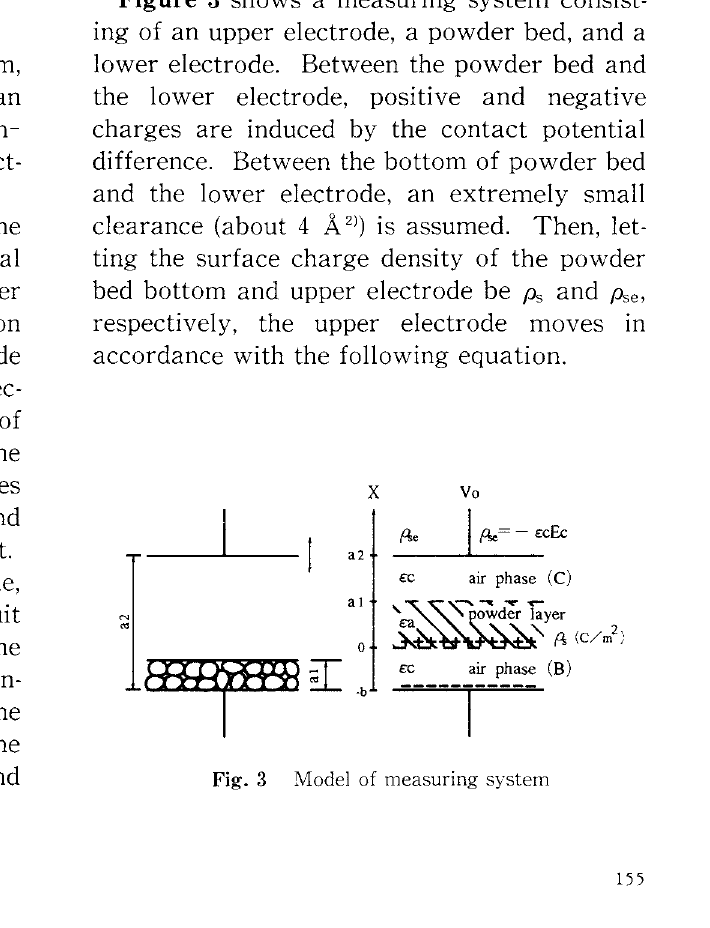
Electrometer Voltmeter